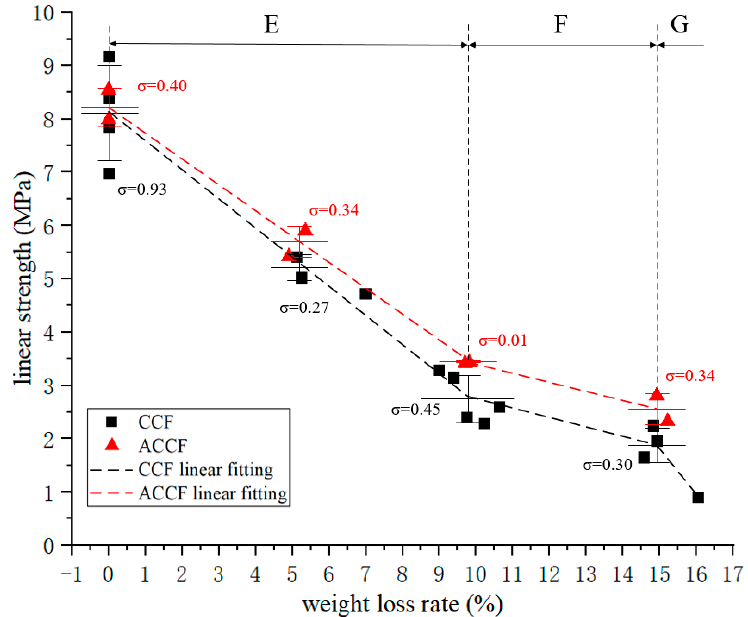
Figure 4. Linear compression strength–weight loss rate curve.